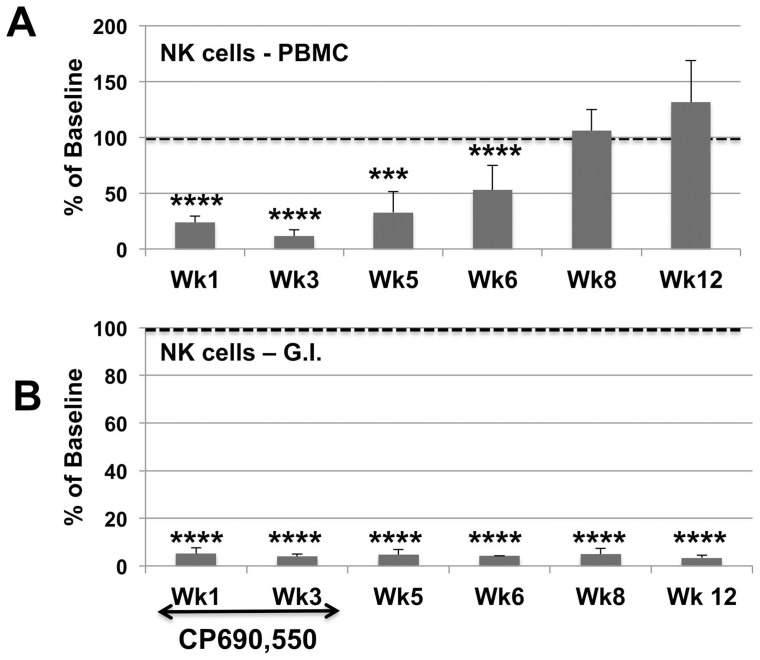
Frequencies of CD3-/CD8+/NKG2a+ (NK cells).Aliquots of cells from the same 6 monkeys as described under Fig. 2 were assayed for the frequencies of CD3−/CD8+/NKG2a+ (NK cells) and the mean % change from baseline values illustrated for A) PBMC samples and B) Gastro-intestinal tissue samples. There was high statistical difference in the values obtained on both PBMC samples (p<0.001) and G.I. tissue samples (all p<0.0) that did not return to baseline values.